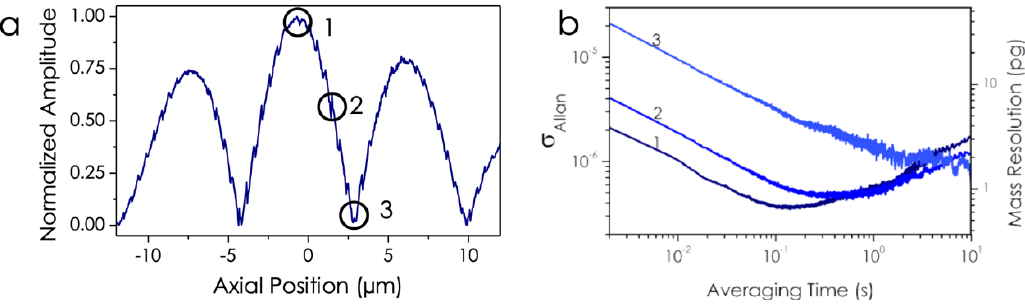
Figure 4. ( a ) Normalized amplitude of the out-of-plane mechanical mode as a function of the measurement position along the axial coordinate. ( b ) Experimental measurement of Allan deviation at three different points, maximum of amplitude, line 1, minimum of amplitude, line 3, and an intermediate point, line 2.